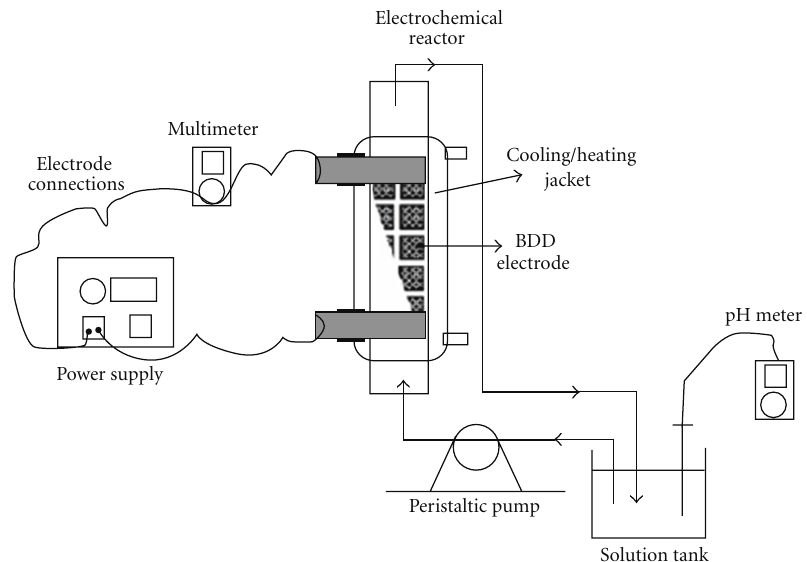
Figure 13: Experimental setup used in the studies for the degradation of Basic Red 29 (BR29) [26].